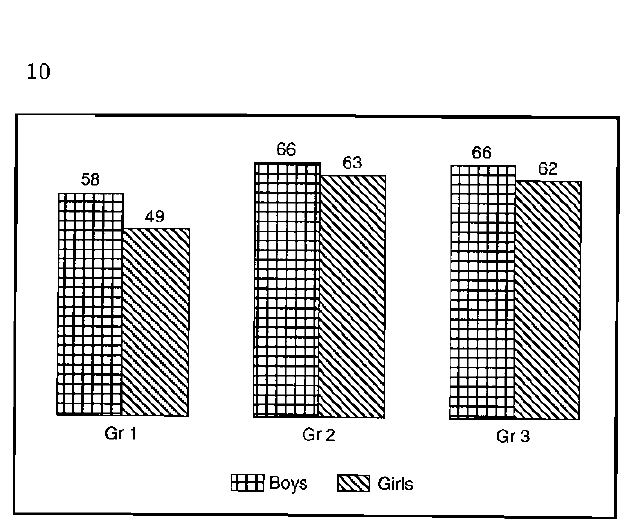
FIGURE 3. Raw scores obtained by each gender in different academic year groups ERROR ANALYSIS